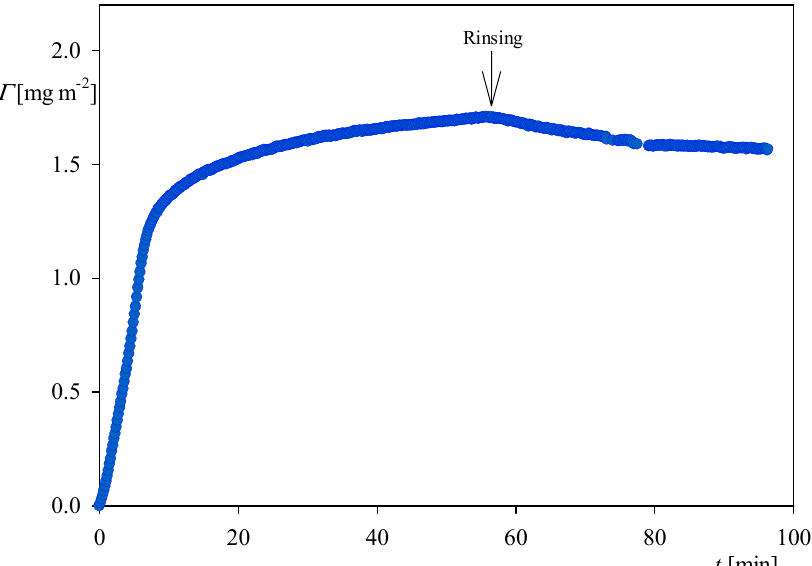
Figure 7. The kinetics of myoglobin adsorption on the silica sensor determined by OWLS, flow rate 2.5 × 10 − 3 cm 3 s − 1 , bulk protein concentration equal to 5 mg L − 1 , ionic strength 0.15 M, pH 4. At the time of 50 min the rinsing run was initiated by flushing pure electrolyte at the same ionic strength and pH.